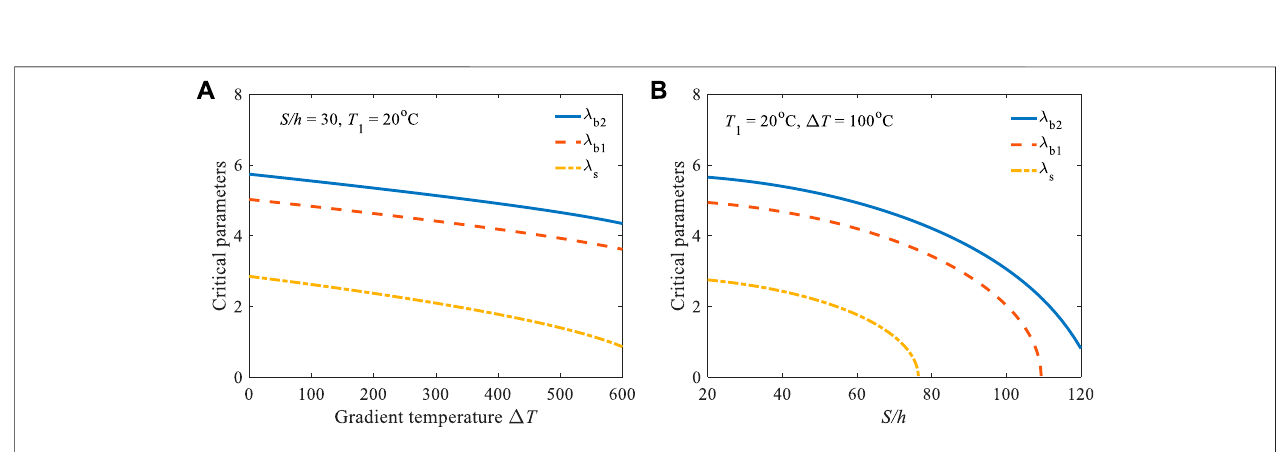
FIGURE 7 | Variations of critical parameters λ b 1 , λ b 2 , and λ s (A) with the gradient temperature change Δ T and (B) with the slenderness S/h .